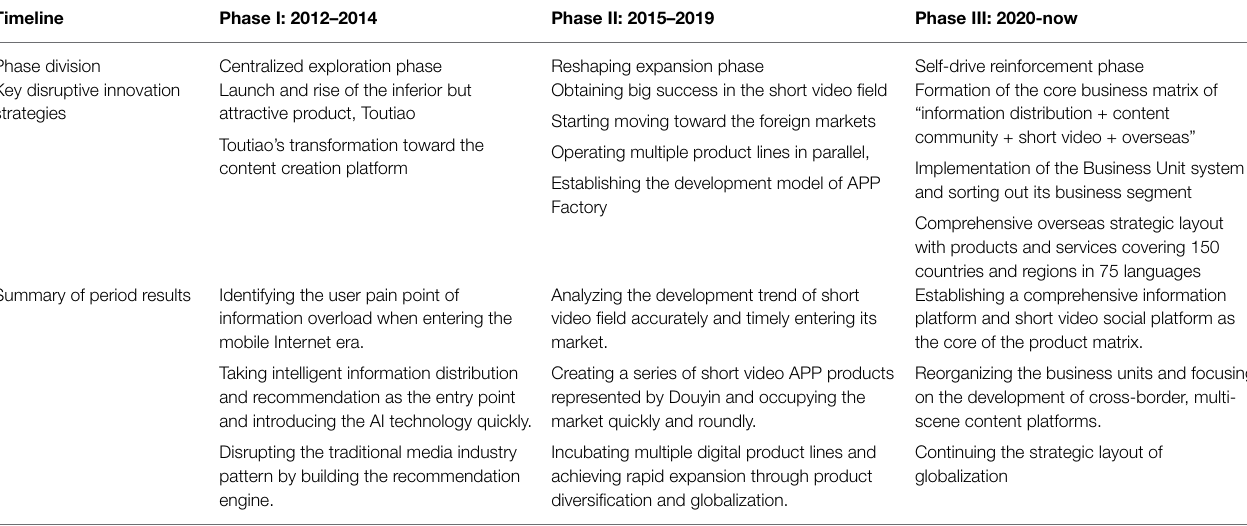
TABLE 1 | Description and division of the case company’s disruptive innovation process.